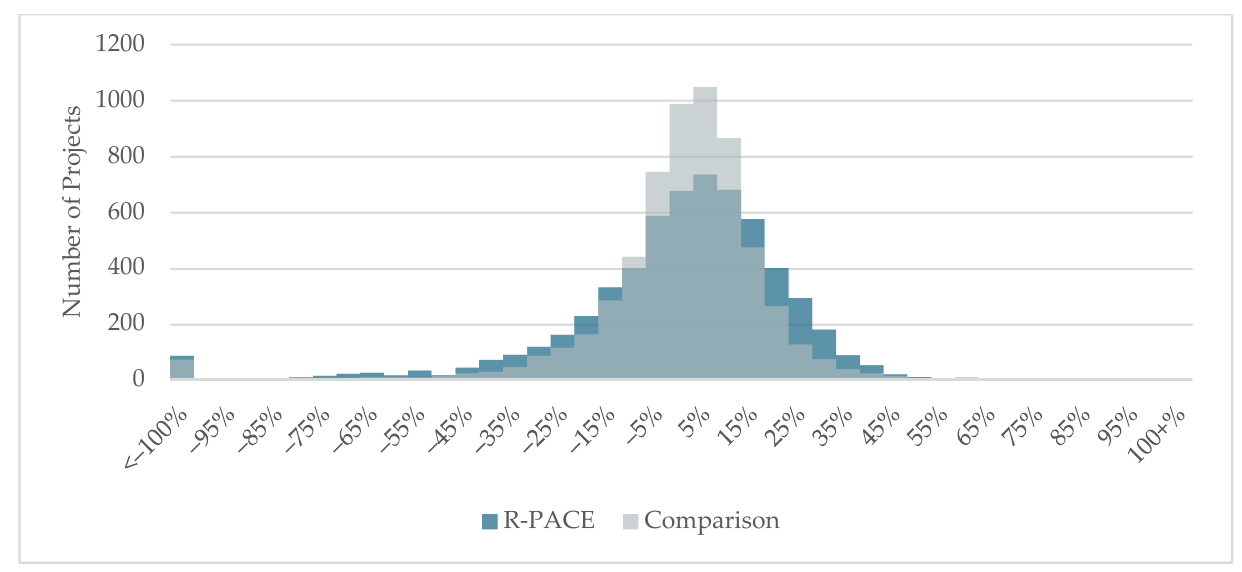
Figure 5. Distribution of household electricity savings from HVAC projects. Note that positive numbers represent savings (reductions in electricity use); negative numbers are negative savings (increases in electricity use).